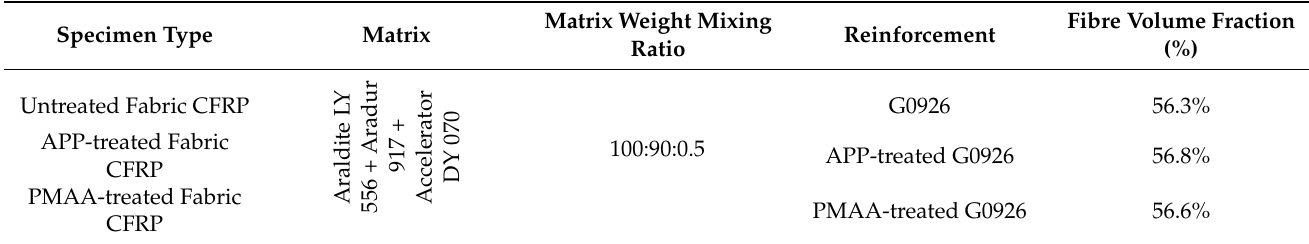
Table 3. Conditions and specifications of manufactured